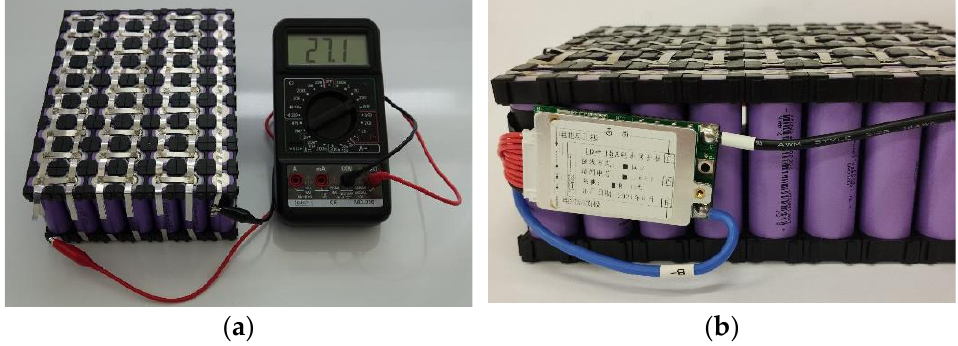
Figure 5. ( a ) Accumulator assembly; ( b ) Protective balancer 10S 15A.